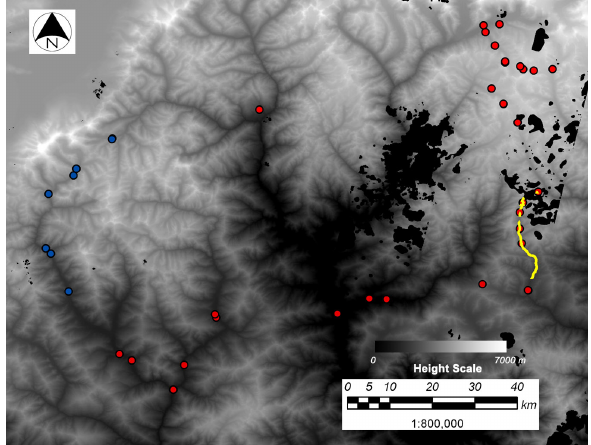
Figure 3. Magnified PRISM DSM mosaic in the northwestern region of Bhutan, showing the location of GPS measurements (yellow: continuous measurement in 2010; red: CPs in 2010; and blue: CPs in 2011; black: masked areas due to clouds). 35 km swath width in triplet mode. It performs along-track triplet stereo observations to generate a precise DSM.